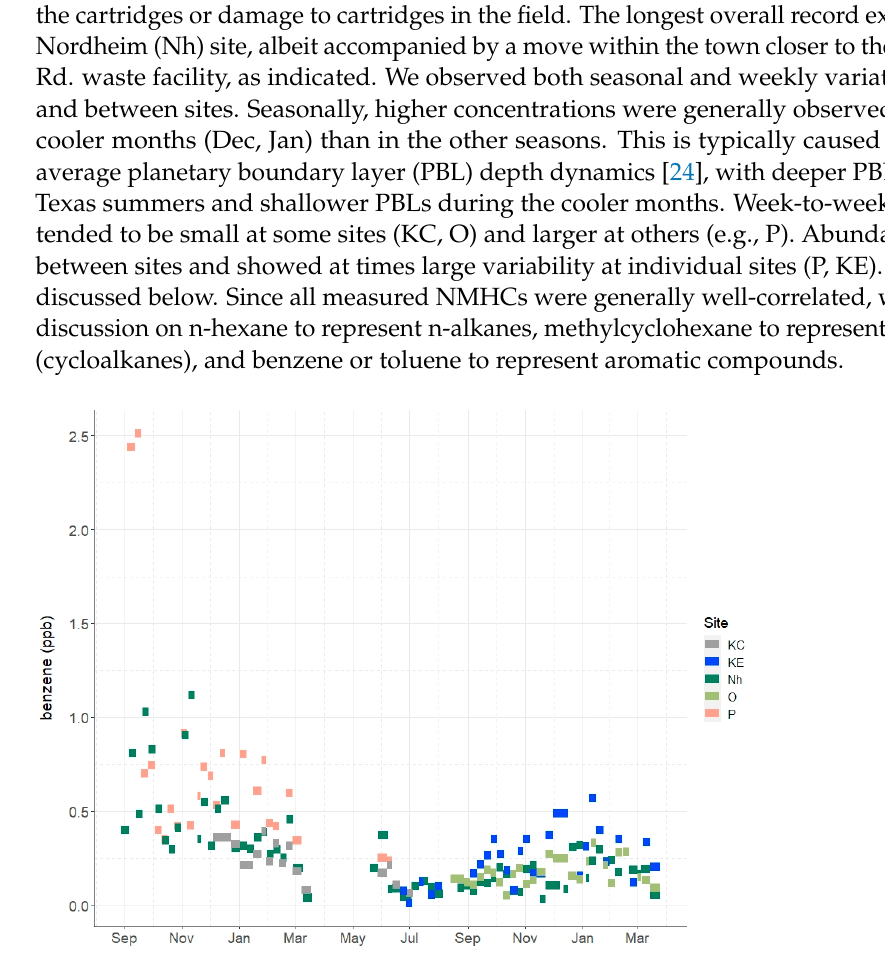
Figure 6. Methylcyclohexane time series for all sites, similar to Figure 5. 4.2. Concentration Anomalies Three periods with signi fi cant deviations occurred at two di ff erent fi eld sites. First, high NMHC levels were recorded at the P site at the beginning of the project, September